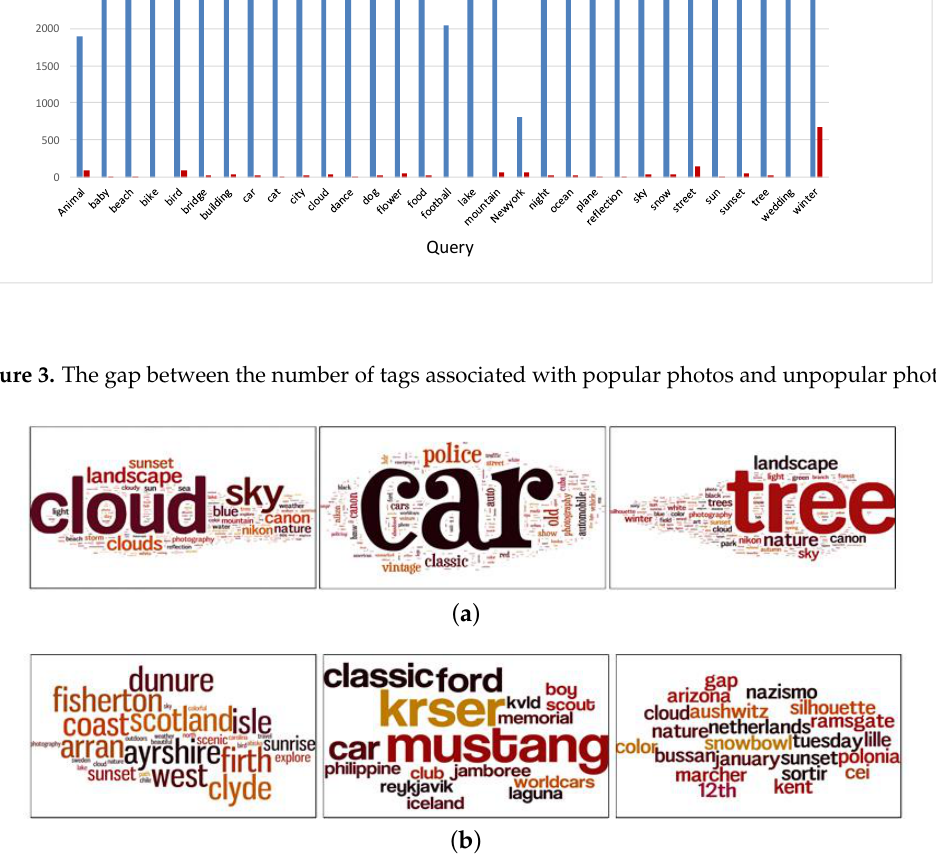
Figure 4. Tagclouds generated from popular and unpopular images on Flickr. ( a ) text associated with popular photos, ( b ) text associated with unpopular